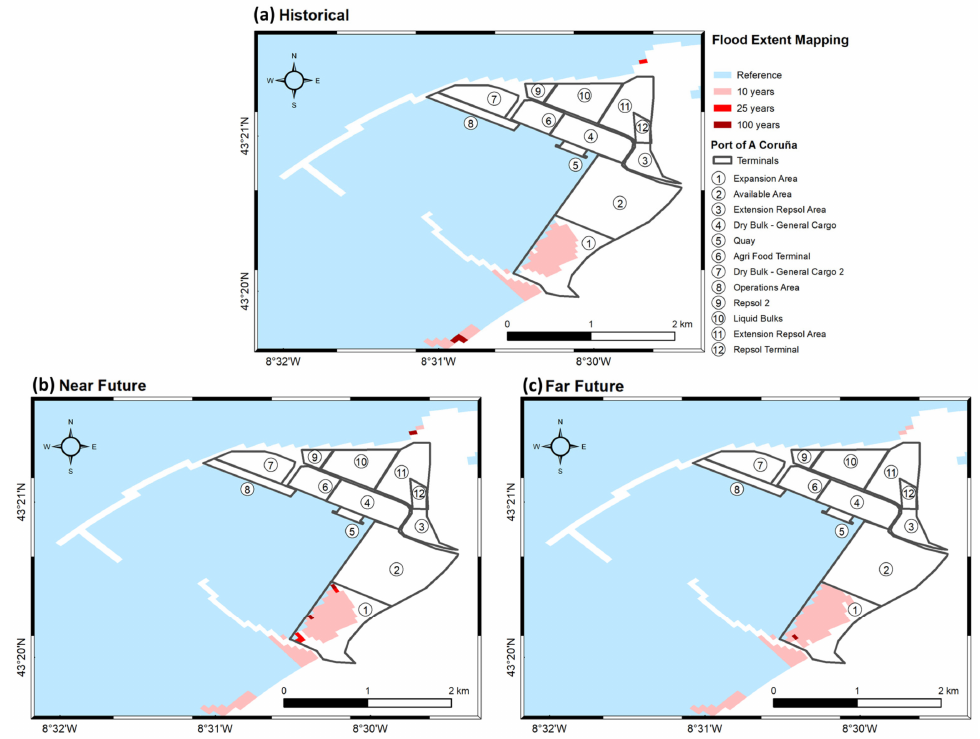
Figure 13. Flood extent mapping of the A Coruña Outer Port terminals (numbers 1–12). Reference scenario under the present climate and 10-, 25- and 100-year return periods are determined for the ( a ) historical (1979–2005), ( b ) near future (2026–2045) and ( c ) far future (2081–2100) climate periods.